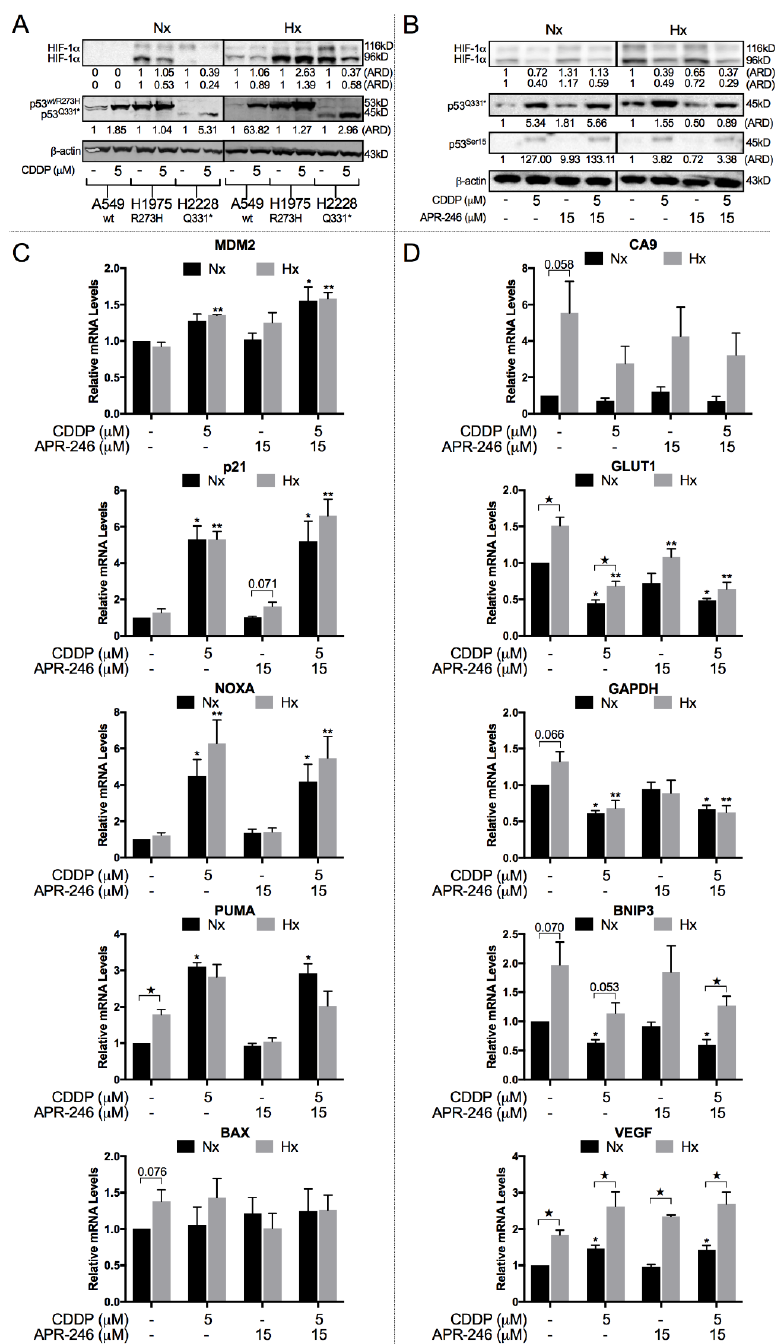
Figure 3. Balance between HIF-1α and p53 protein levels and transcriptional activity. ( A ) A549 wt , NCI-H1975 R273H , and NCI-H2228 Q331 * cell lines were treated with either vehicle or CDDP under normoxic and hypoxic conditions. Protein levels of HIF-1α 116 kDa (processed), HIF-1α 96 kDa (unprocessed), full p53 wt/R273H , and truncated p53 Q331 * were determined by Western blotting. β-actin was used as internal control. ( B – D ) NCI-H2228 cells were treated for 24 h with with CDDP, APR-246, or combined therapy under normoxic and hypoxic conditions. ( B ) Protein levels of HIF-1α 116 kDa (processed), HIF-1α 96 kDa (unprocessed), p53 Q331 *, and p53-serine 15 were determined by Western blotting. β-actin was used as internal control. ( C , D ) Relative mRNA expression levels of p53 ( C ) and HIF-1α ( D ) transcriptional targets. Expression levels are presented relative to the vehicle-treated sample under normoxia as mean ± SEM of 3 independent experiments ( ★ p < 0.05 normoxia vs. hypoxia; * p < 0.05 compared to vehicle-treated sample under normoxia; ** p < 0.05 compared to vehicle-treated sample under hypoxia.). ARD: Adjusted Relative Density; Nx: normoxia; Hx: hypoxia.